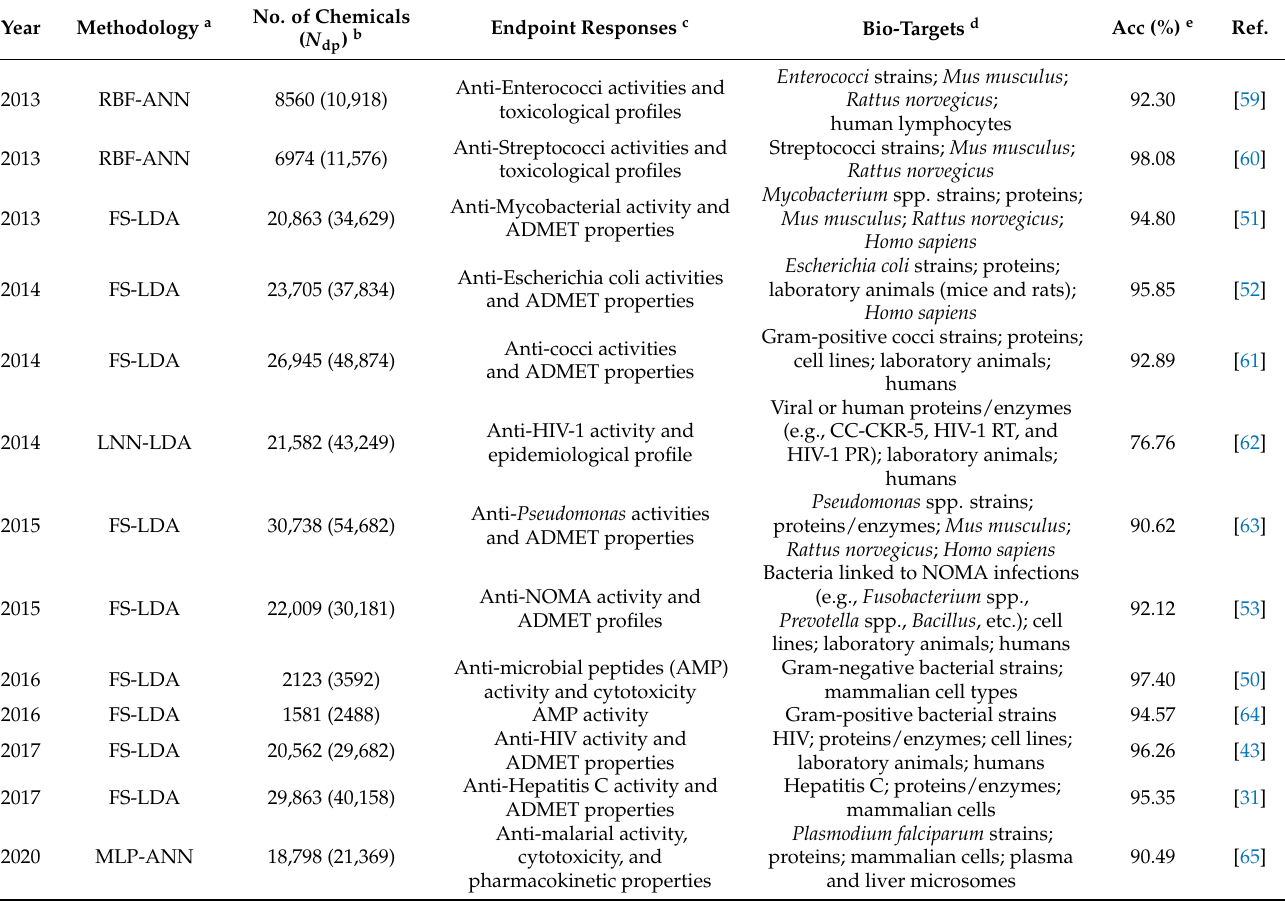
Table 3. Selected multitasking classification modeling studies in antimicrobial and antiviral research. Year Methodology